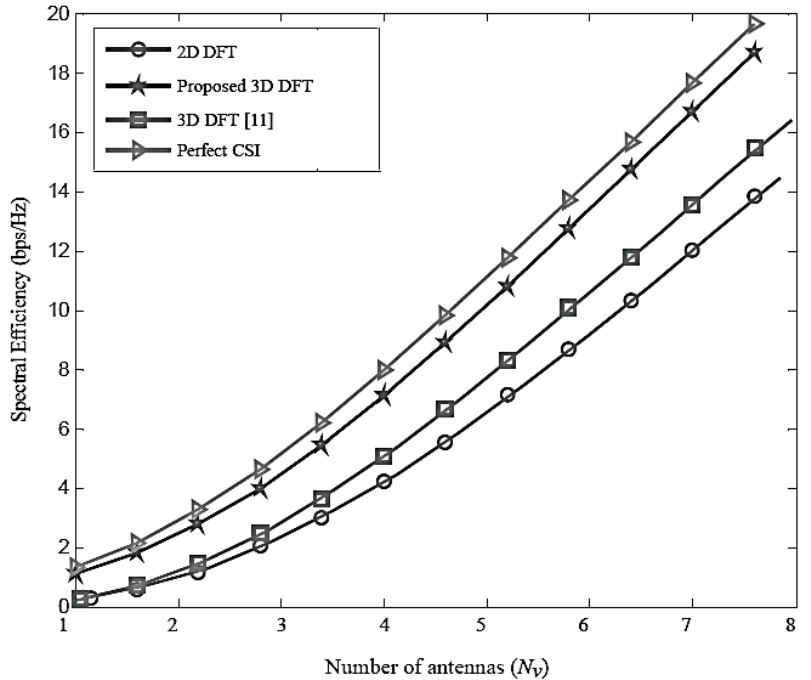
Figure 13. Spectral efficiency comparison against the number of antennas for the proposed 3D MIMO codebook scheme with other